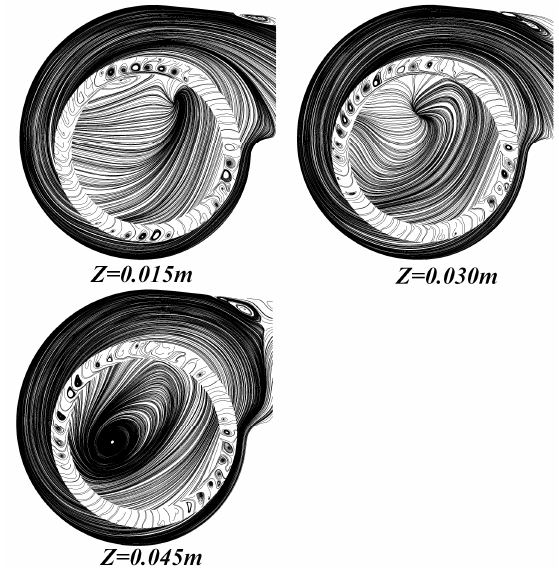
Figure 9. Streamline of cross-sections at different positions (Q/Qn = 0.031).